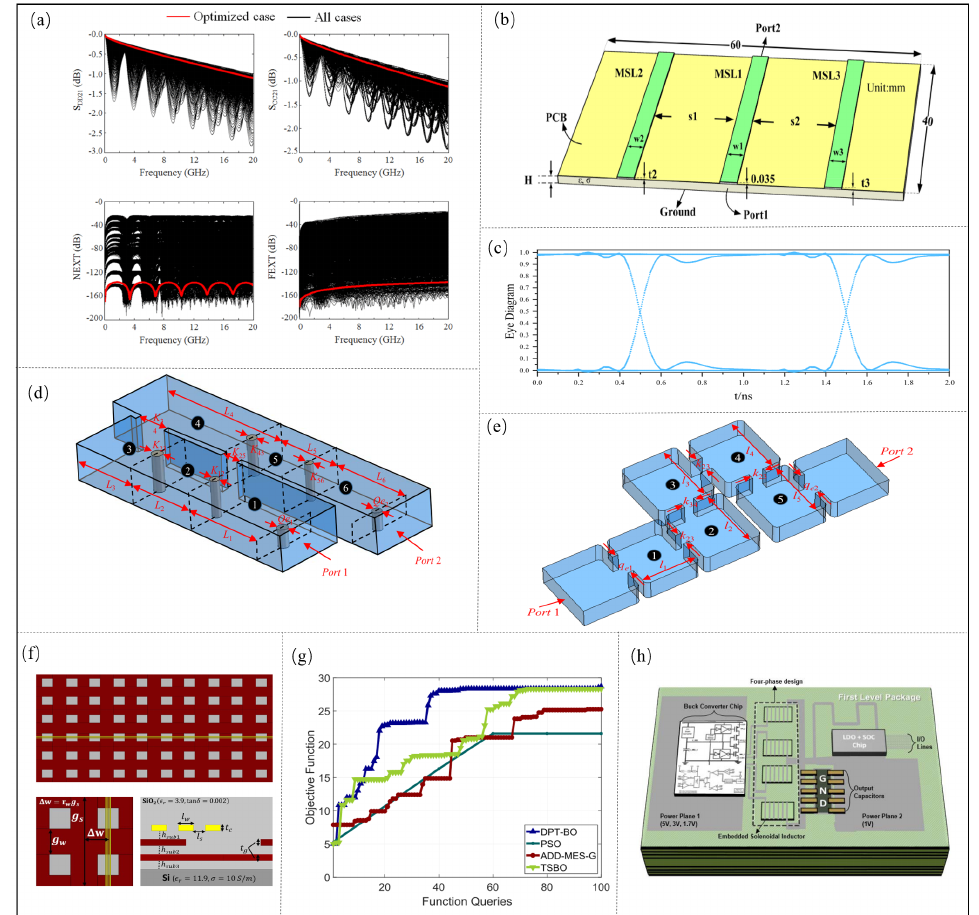
Figure 8. ( a ) Validation of channel optimization result by GA. Adapted with permission from [59]. ( b ) Structure and dimension of a high-speed channel. Adapted with permission from [31]. ( c ) Eye diagram obtained by the CST commercial software based on the optimized ten parameters. Adapted with permission from [31]. ( d ) Structure of x-band filter. Adapted with permission from [79]. ( e ) Structure of bandpass filter. Adapted with permission from [79]. ( f ) Structure of the high-speed channel. Adapted with permission from [80]. ( g ) Performance comparison between DPTBO algorithm and other algorithms. Adapted with permission from [80]. ( h ) Two-chip SiP IVR Architecture. Adapted with permission from